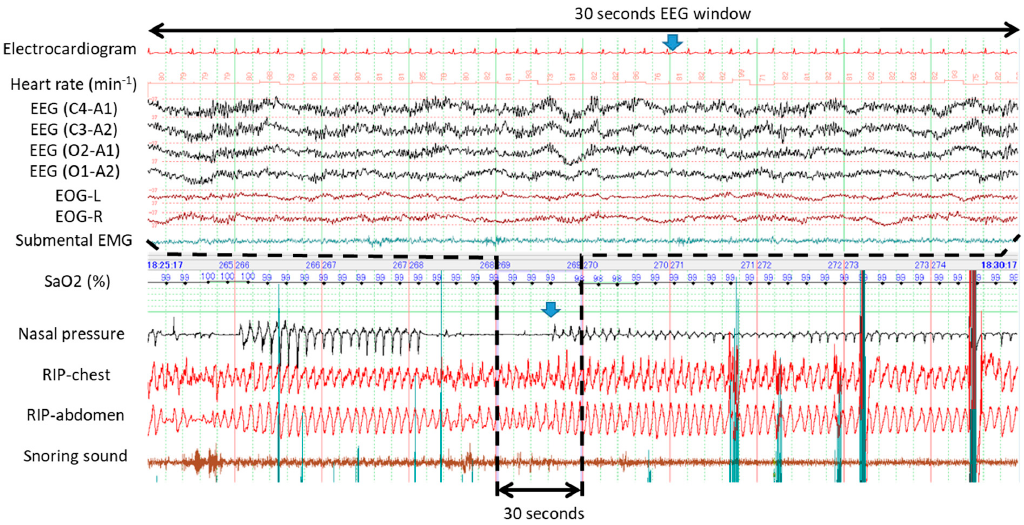
Figure 4. Five minute polysomnographic recordings of a series of obstructive apneas and hypopneas during propofol-induced sleep. Note that the second obstructive apnea shown by the arrow was resolved by an abrupt increase of airflow which was followed by long-lasting obstructive hypopneas with flattened nasal pressure signal indicating inspiratory flow limitation. No desaturation, no cortical arousal, and no heart rate change were observed throughout the 5-minute recording.